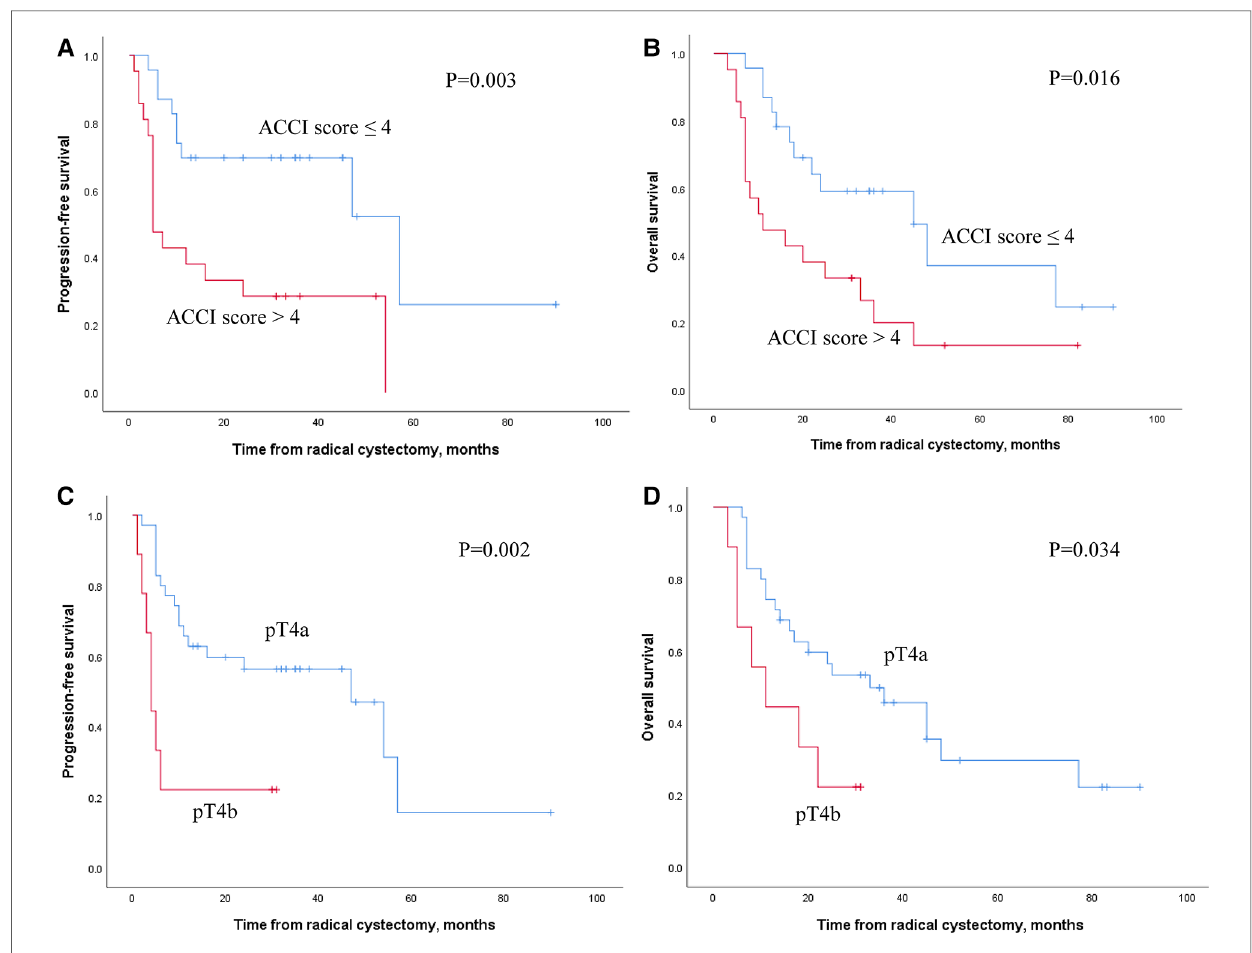
FIGURE 2 Kaplan – Meier plots for PFS and OS according to ACCI score and pT4 subgroup.